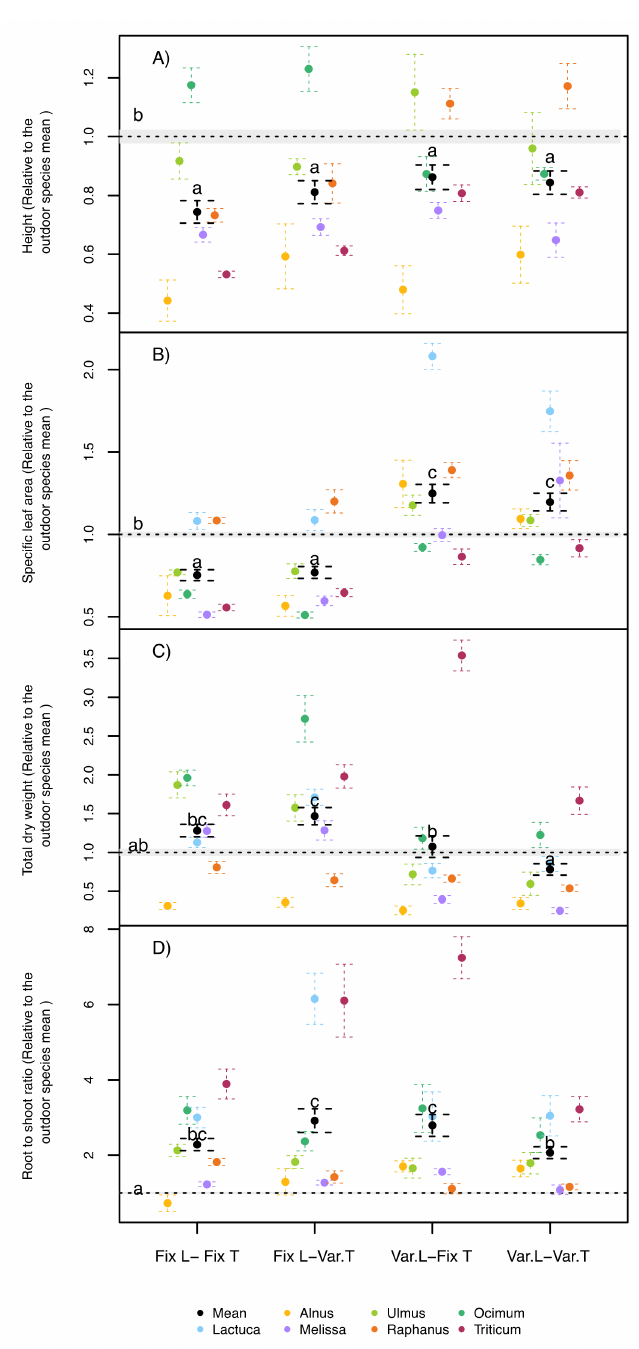
Figure 2. ( A ) Plant height, ( B ) specific leaf area, ( C ) total plant dry weight, and ( D ) root to shoot ratio of seven different species normalized to an outdoor control treatment under four treatment combinations (fixed, Fix., or variable, Var.) of two environmental factors (light, L, and air temperature, T). Error bars correspond to the standard error. N = 9 for each species, where N for the average = 63. Different letters indicate significant differences ( p < 0.05, by Tukey post hoc tests) among treatments (including the outdoor trials) using species as random